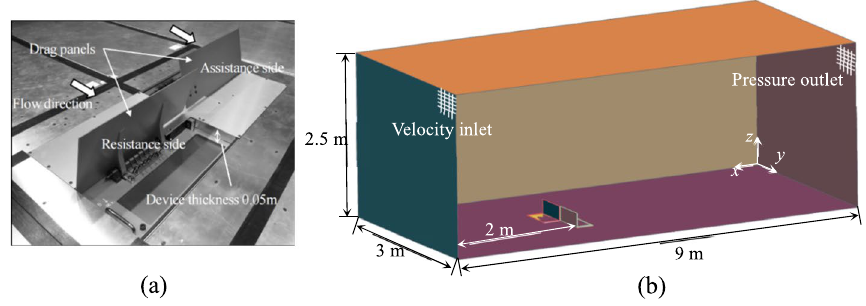
Fig. 6 Algorithm validation: ( a ) the test model and ( b ) the computational model [15]